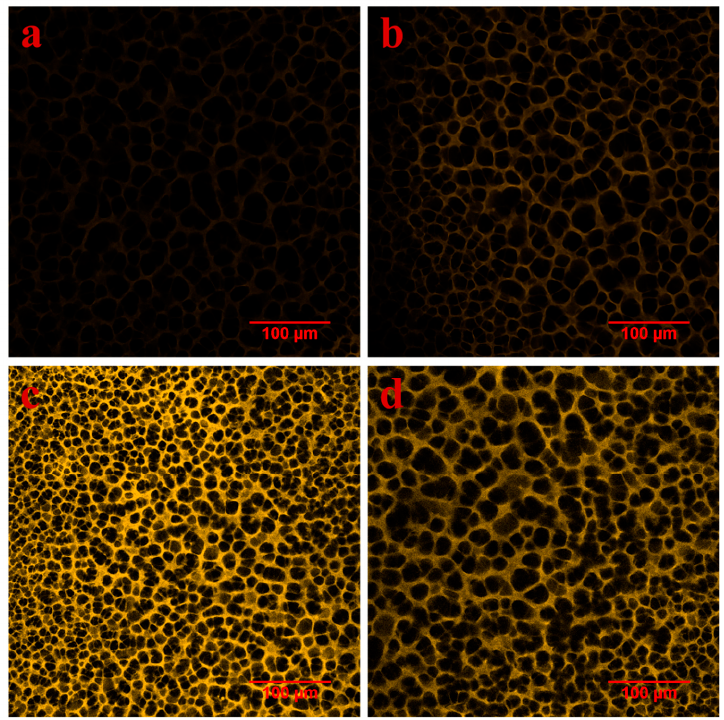
Figure 5. CLSM images of MF or UF membranes. ( a , b ) Image of the surface of MF membranes after they were used to filter Syn 7942 cells under a feed pressure of 0.34 bar ( a ) or 1.00 bar ( b ). ( c , d ) Images of the surface of UF membranes after they were used to filter Syn 7942 cells under a feed pressure of 0.34 bar ( c ) or 1.00 bar ( d ). The imaging layer is 20 um depth from the surface of the MF or UF membrane.